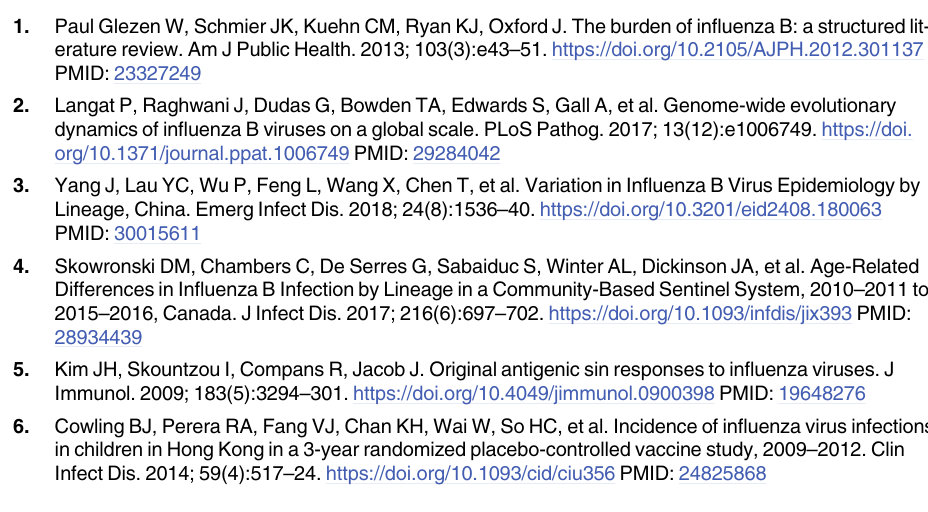
S2 Table. Sensitivity analysis on different time for antibody titer reaching the peak and dif- ferent period for short-term waning rate. The time for antibody titer reaching the peak and the period for short-term waning rate were fixed to be 4 weeks and 6 months after infection in the model. This table compared the estimates when the time for antibody titer reaching the peak was 2 weeks and 8 weeks, and when the period for short-term waning rate was 3 months and 9 months. S3 Table. Model adequacy for fitting the data. This table showed the proportion of observa- tion which lied inside the 95% credible intervals of the post-infection titer by lineage of PCR- confirmed infection and lineage